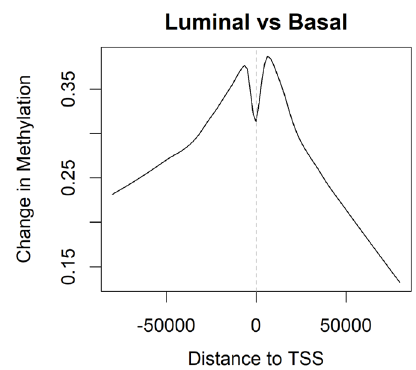
Figure 4. Average methylation change by genomic position relative to TSS. Changes are averaged over all genes. Negative distances are downstream of TSS. Vertical axis shows base 2 logit differences.